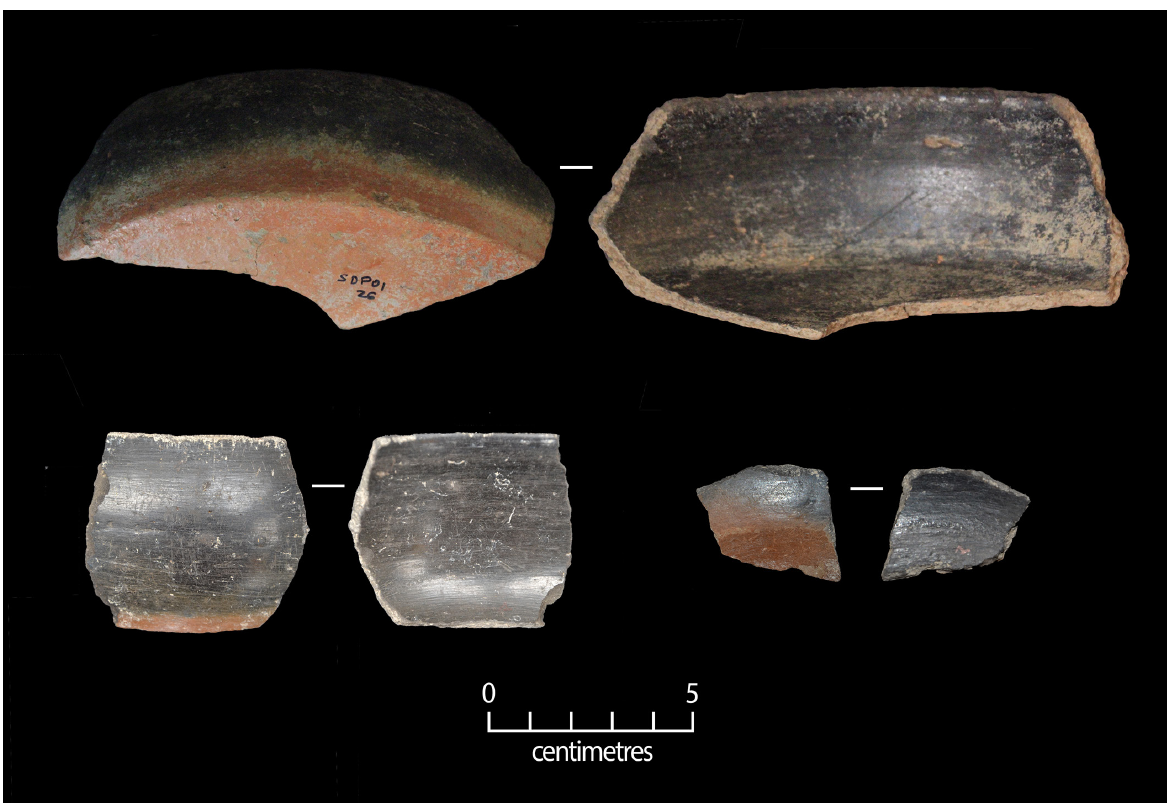
Figure 24: External and internal surfaces of three Class 7 variant 1 potsherds.